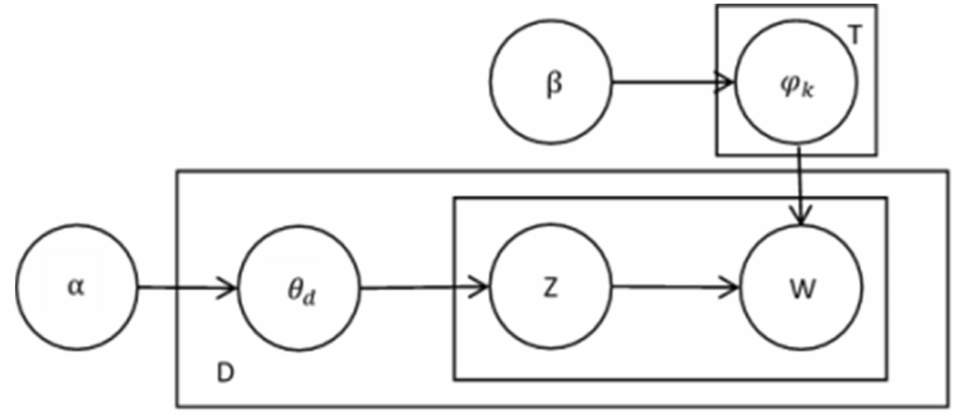
Figure 2. LDA probability model